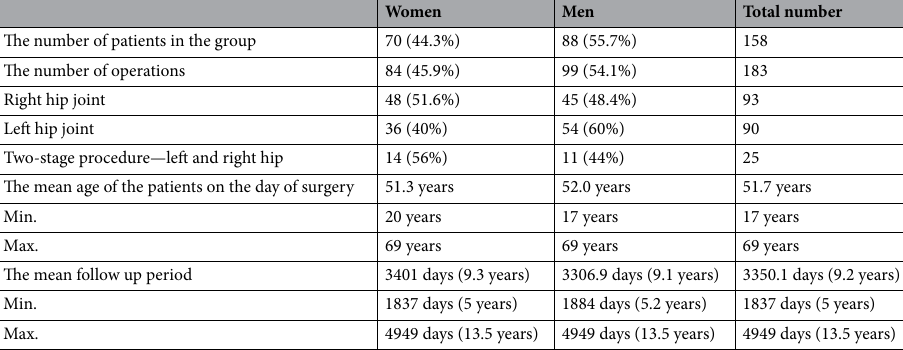
Table 1. Characteristic features of the study group, divided by gender.